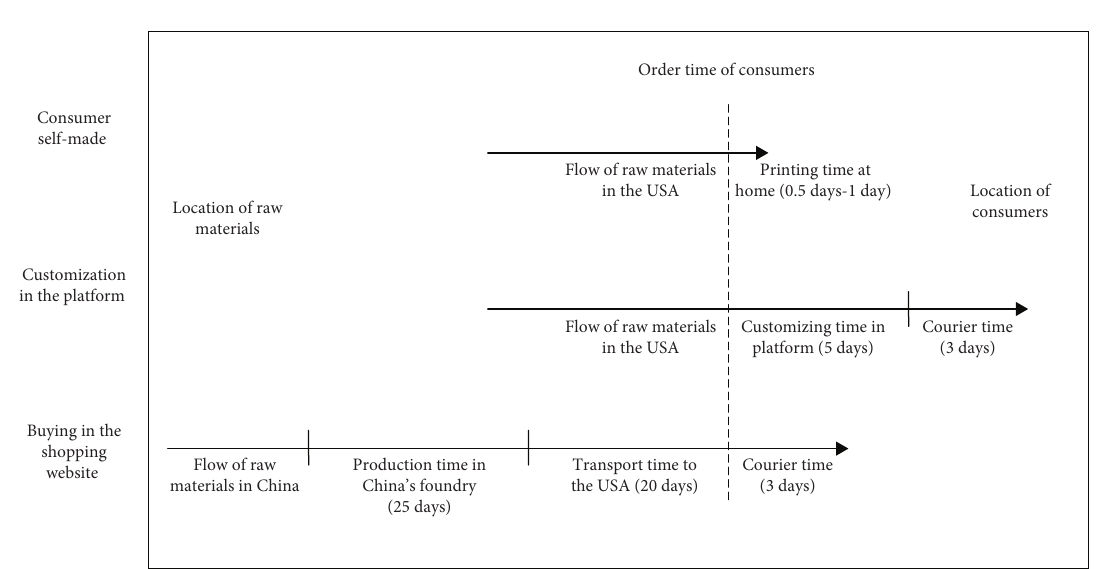
Figure 4: Comparison of the lengths of the supply chains of the three channels. Data source: authors.